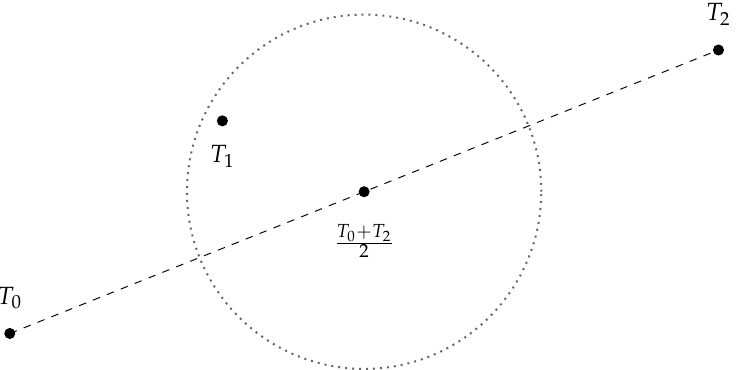
Figure 5. Reasonable expectation of the distribution of the template feature vector T 0 , T 1 , T 2 .